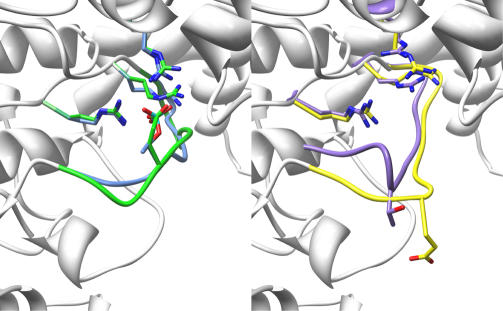
Active and Inactive Conformations of the CDK2 Activation LoopLeft: Blue represents the crystal structures of the phospho-CDK2/cyclin A complex, and green represents the T160E-predicted active-like conformation. The Arg cluster is shown in stick representation. The carboxylate group of Glu160 and the phosphate group of pThr160 are almost exactly superimposed. Right: Purple represents the crystal structure of unphosphorylated CDK2/cyclin A, and yellow represents the predicted inactive conformation of T160E. These two structures are qualitatively similar in that Thr160 and Glu160 both point out into solvent and the Arg cluster is better solvated. Figures prepared with Chimera [72].